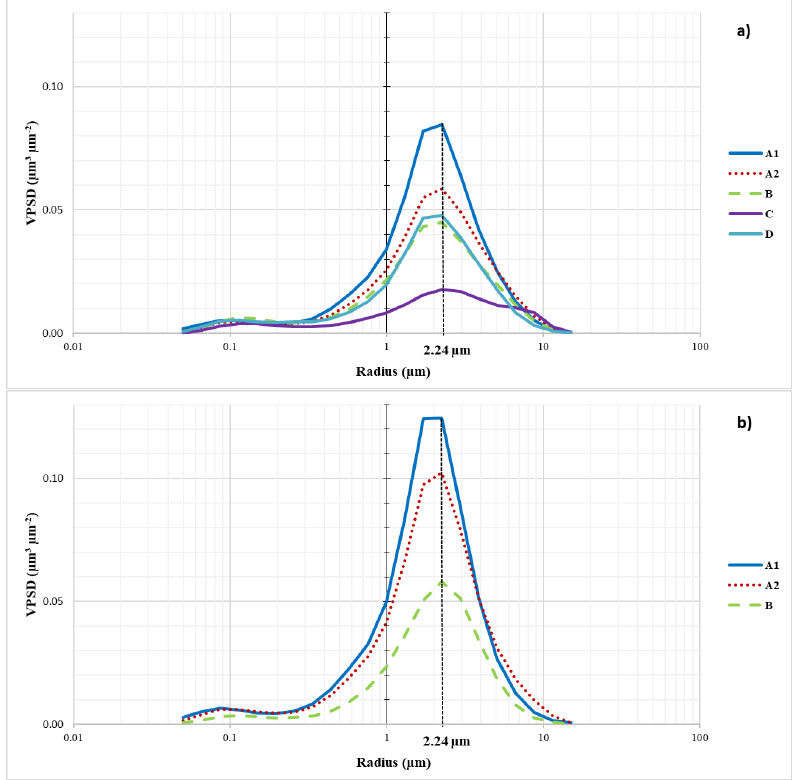
Figure 10. The Volume Particles Size Distribution (VPSD) in PR from 2000 to 2020 for ( a ) all cases and ( b ) dusty cases ( [ PM 10 ] ≥ 35 µ g.m − 3 ) according to the following ratios: A1 = PM 2.5/ PM 10 < 0.2, A2 = 0.2 ≤ PM 2.5/ PM 10 < 0.4, B = 0.4 ≤ PM 2.5/ PM 10 < 0.6, C = 0.6 ≤ PM 2.5/ PM 10 < 0.8 and D = PM 2.5/ PM 10 ≥ 0.8.